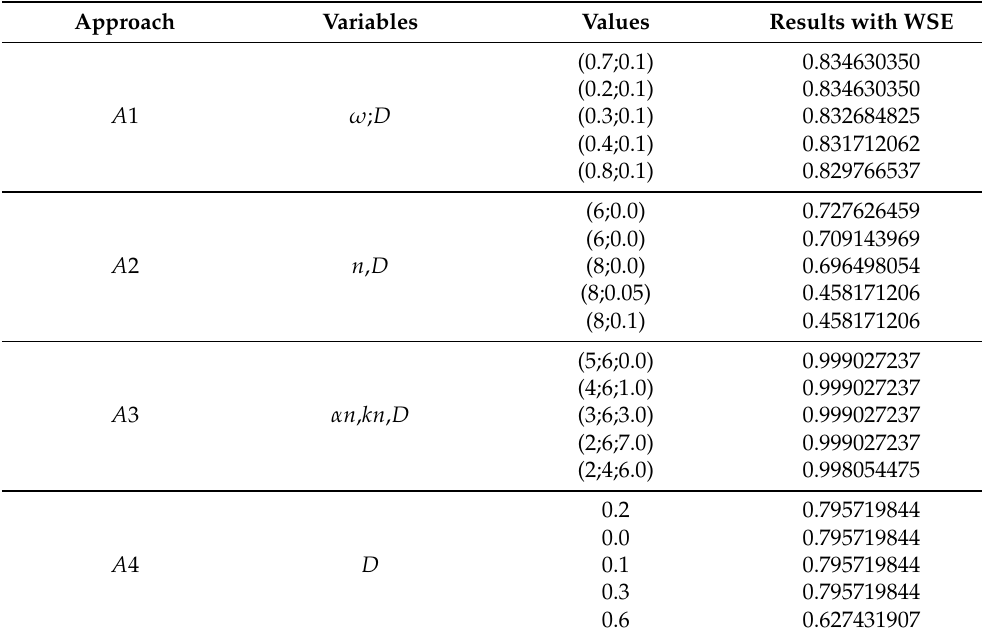
Table 3. Best five accuracies obtained and their respective parameters’ values of each approach previously described. Approach Variables Values Results with